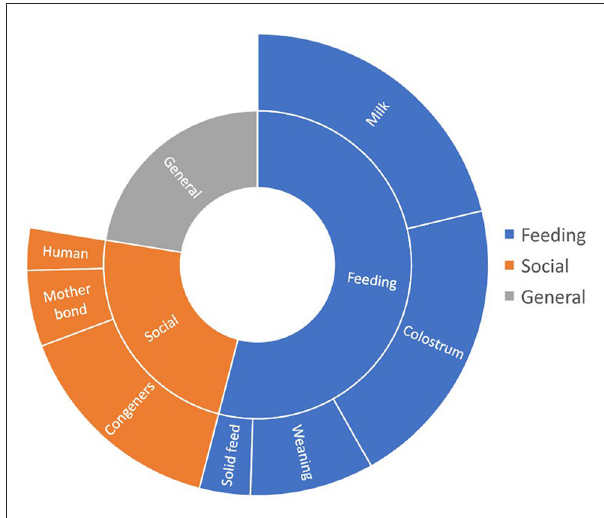
FIGURE4 Distribution of papers by topic of publications when searching for feeding and social management strategies. The size of each is proportional to the number of publications found.